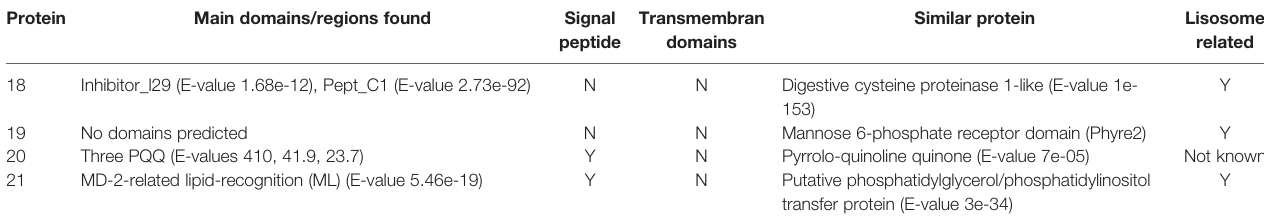
Proteins extracted from the 9 gel slices. A : number of peptides identi fi ed, the corresponding contig and relative status, number of Amino acids, predicted MW and PI. More details are reported in Supplementary Files 1 , 3 . B : main conserved domains (see Figure 3 ), presence of signal peptide and/or transmembrane domains, similar proteins, and correlation with lysosome environment. More details are reported in Supplementary File 3